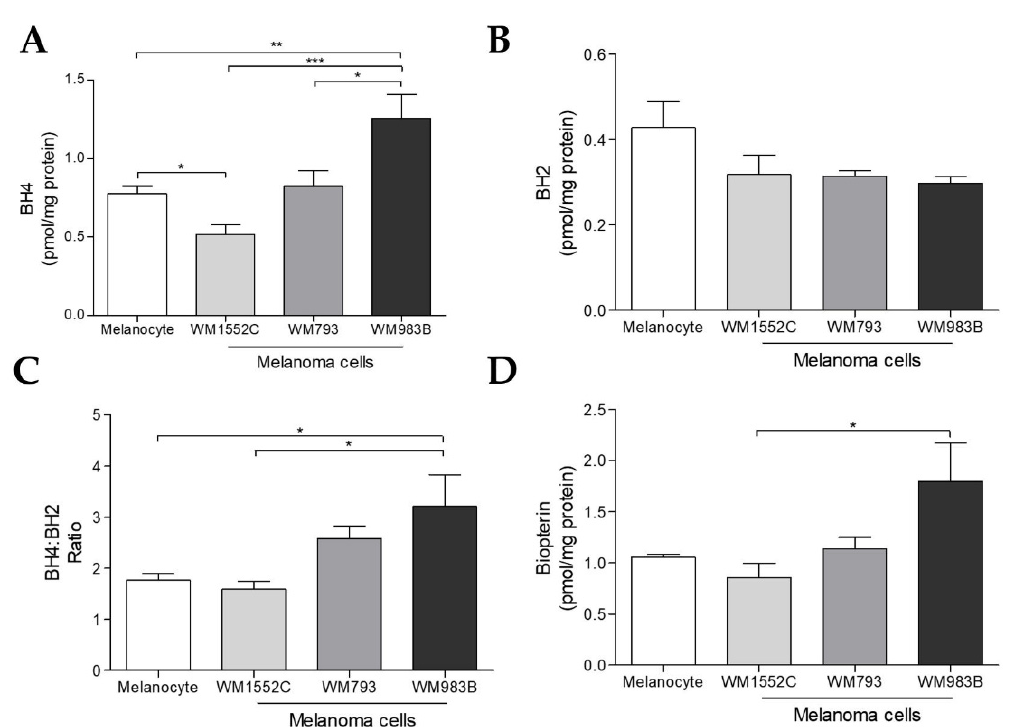
Figure 2. Tetrahydrobiopterin concentration is higher in metastatic melanoma cells. The amounts of BH4 ( A ); BH2 ( B ), BH4:BH2 ratio ( C ), and total biopterin ( D ) of melanocytes, WM1552C, WM793, and WM983C melanoma cells were determined by HPLC. Values are reported in the bar graphs and expressed as the means ± S.D. The experiments were performed in quintuplicate, and p -values were based on the one-way ANOVA test, followed by Bonferroni’s post-test; *, p < 0.05; **, p < 0.01; and ***, p < 0.001.